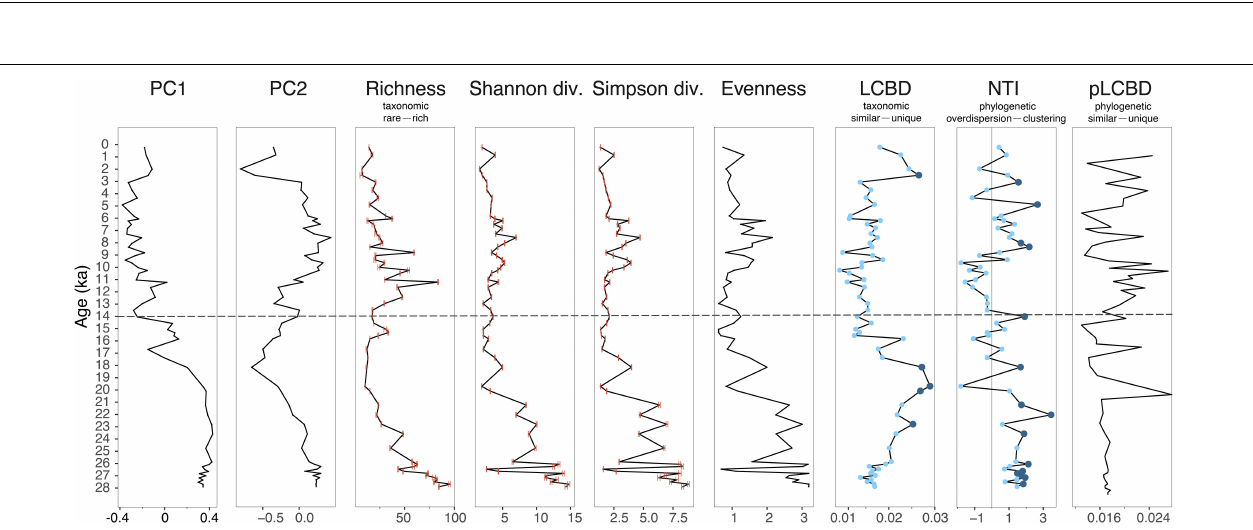
FIGURE 4 | Plant assemblage composition and taxonomic and phylogenetic diversity derived from sedimentary ancient DNA. The measurements from left to right are first and second axes of a principal component analysis (PC1 and PC2), taxonomic richness, Hill’s N1 (exponential of Shannon diversity), Hill’s N2 (inverse Simpson diversity) and evenness, abundance-weighted local contributions to beta diversity (LCBD), abundance-weighted nearest taxon index (NTI), and phylogenetic abundance-weighted local contributions to beta diversity (pLCBD). Maximum and minimum values of the 100 resampling runs are indicated as error bars in red. Significance of NTI and LCBD are colored in dark blue when the values are significant ( p < 0.05) and light blue when the values are not significant ( p > 0.05).